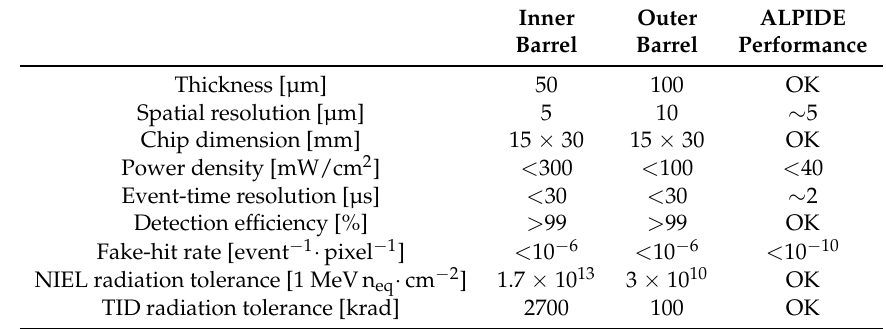
Table 1. Requirements for a sensor in the Inner and Outer Inner Tracking System (ITS) Barrel and the achieved ALPIDE performance. Taken from